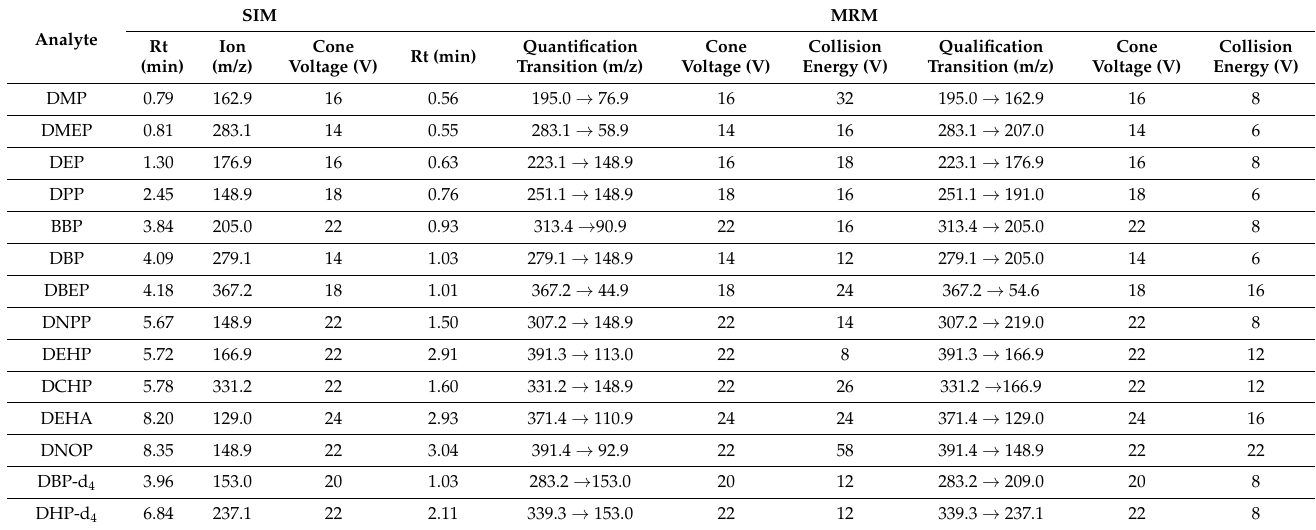
Table 4. MS and MS/MS parameters of the selected plasticizers and